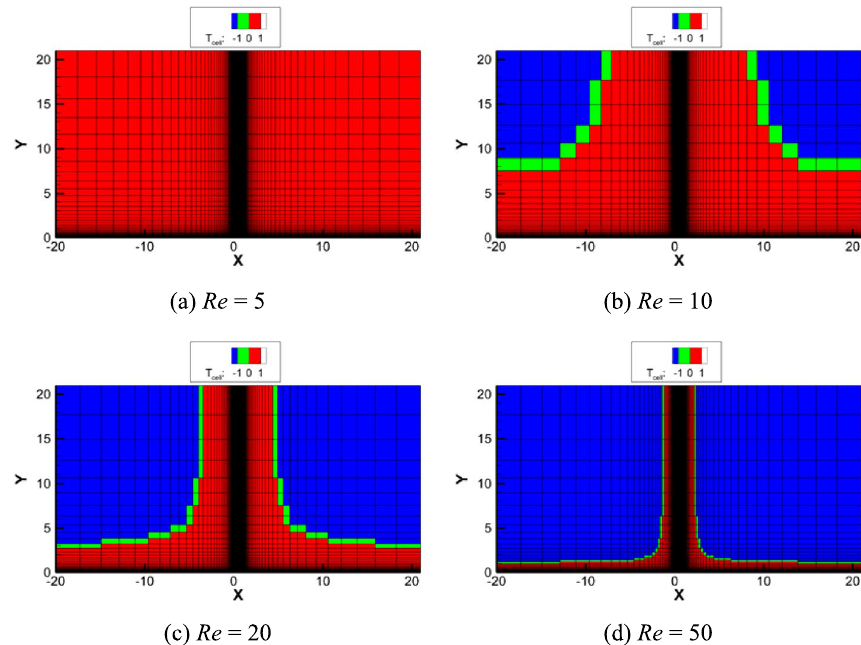
Fig. 9 Distribution of the DUGKS cell and the N-S cell for flow around a flat plate with different Reynolds numbers in the slip flow